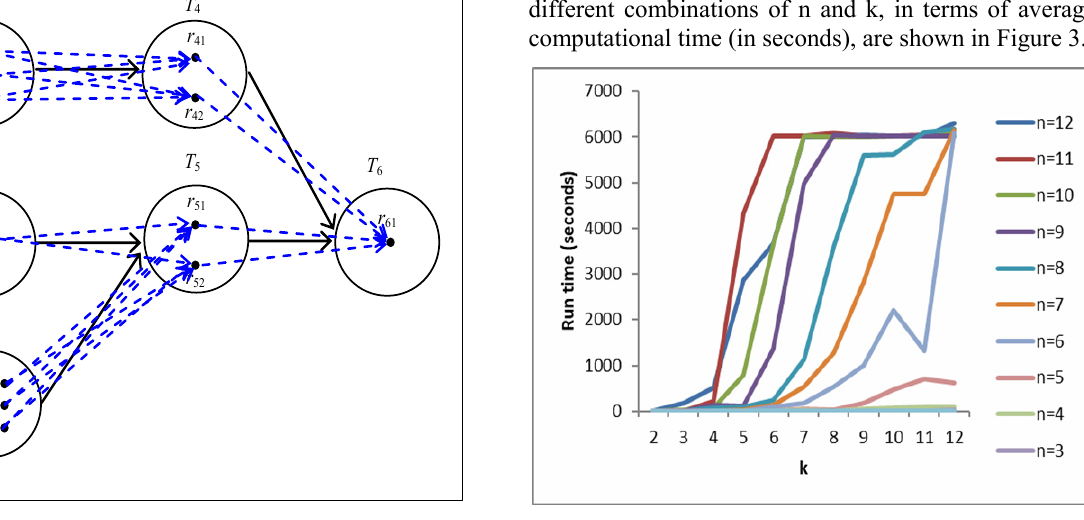
Figure 2. An example of the total transportation tasks to be considered in the SRS.